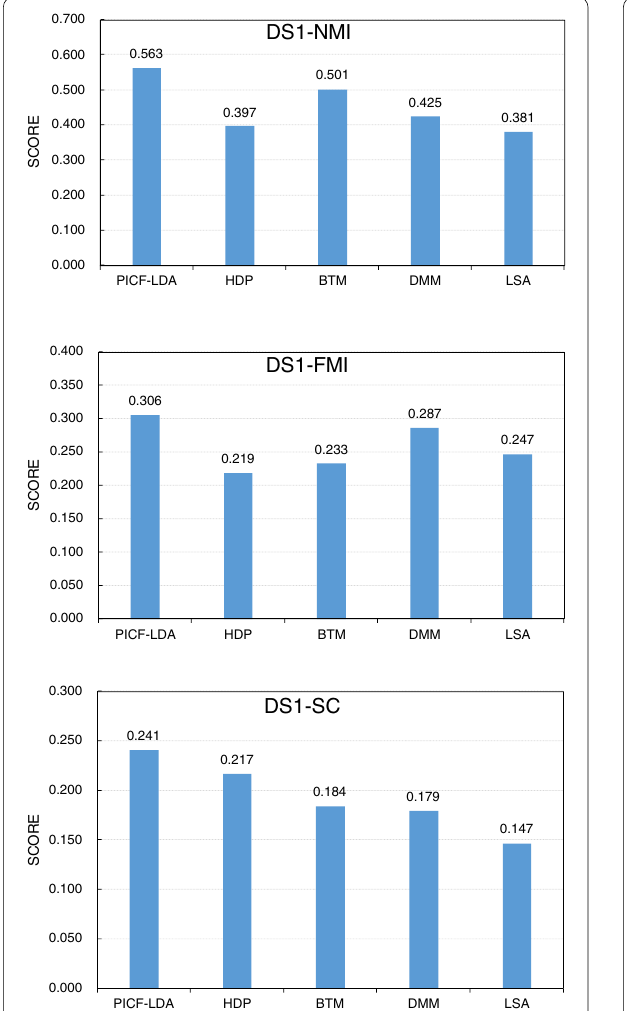
Fig. 9 Performance comparison between PICF-LDA and non-LDA models in DS1